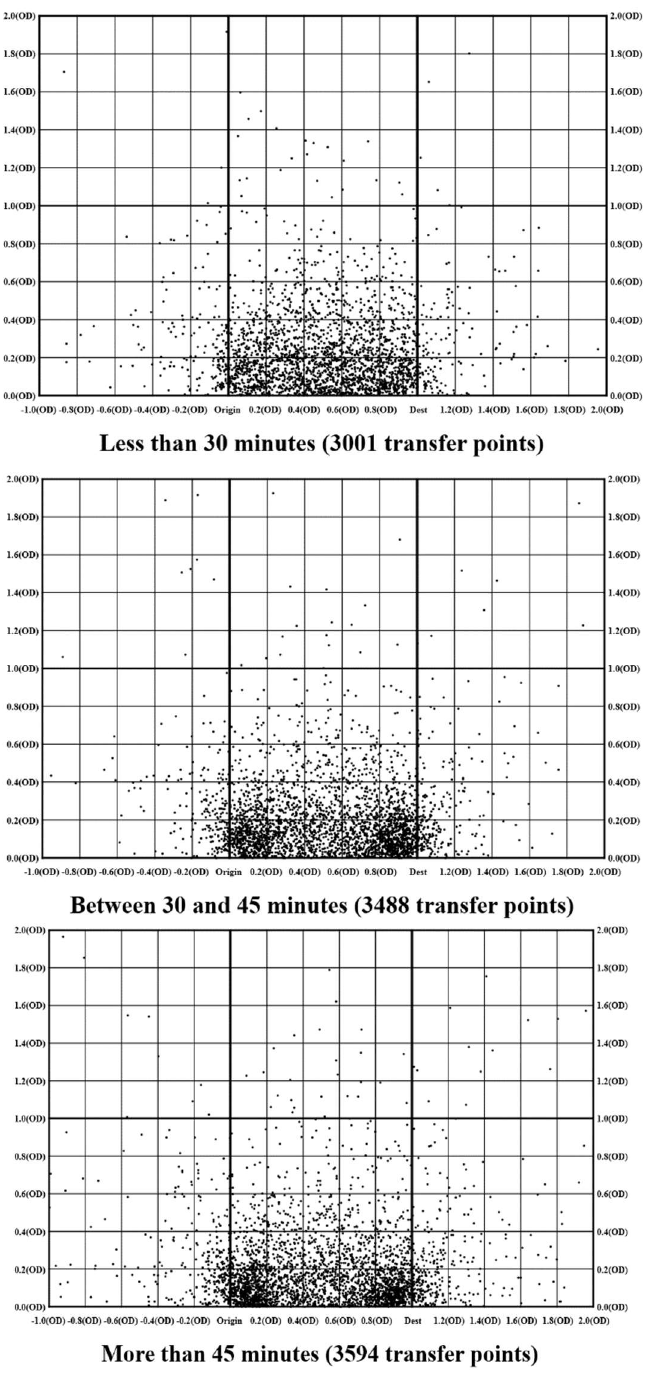
Figure 8. Distribution of transfer points.